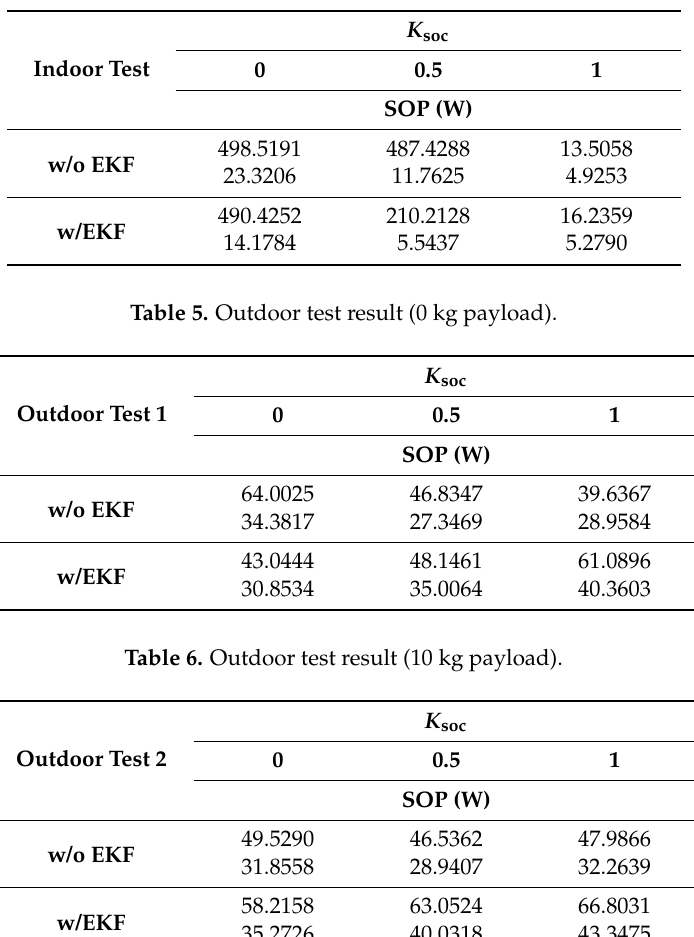
Table 4. Indoor test result (HPPC).